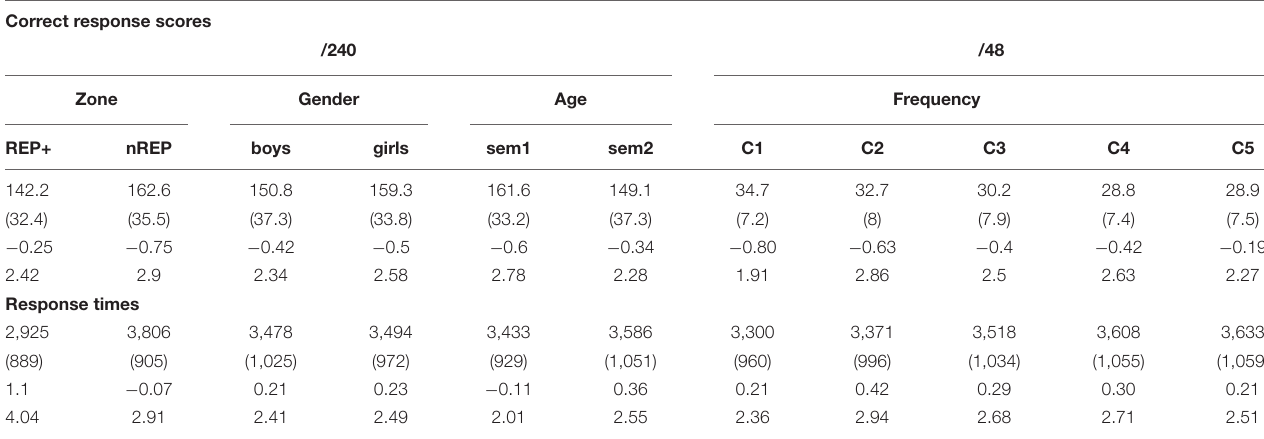
TABLE 1 | Mean (standard deviations in brackets; Skewness and Kurtosis) correct response scores and response times as a function of zone, gender, age and word frequency. Correct response scores